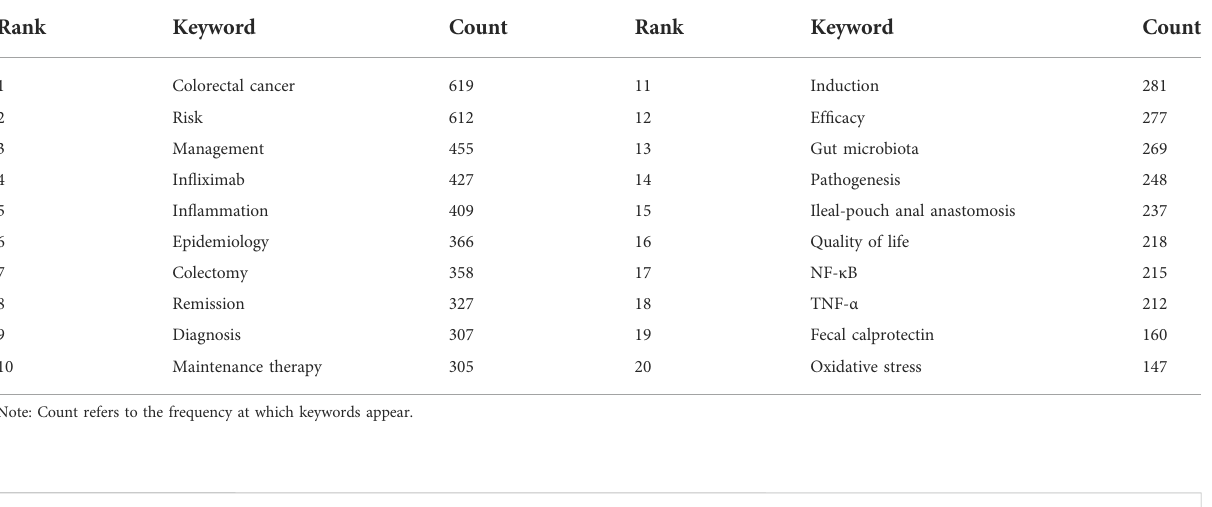
TABLE 7 Top 20 keywords with the highest count in UC